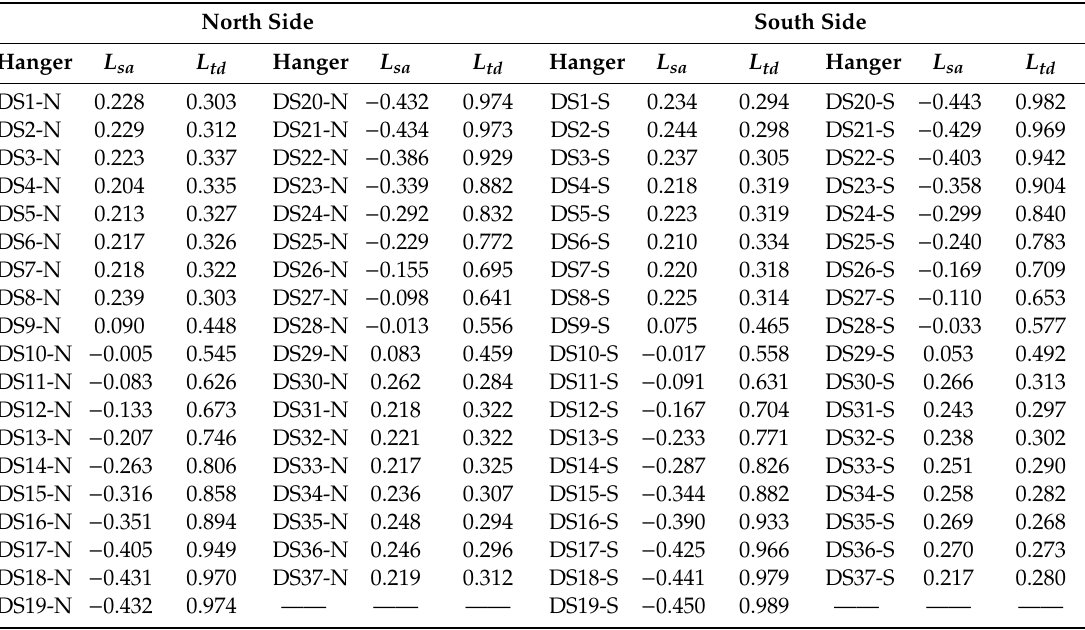
Table 3. Target values of the control parameters of tensioning round 1 (Unit: m).